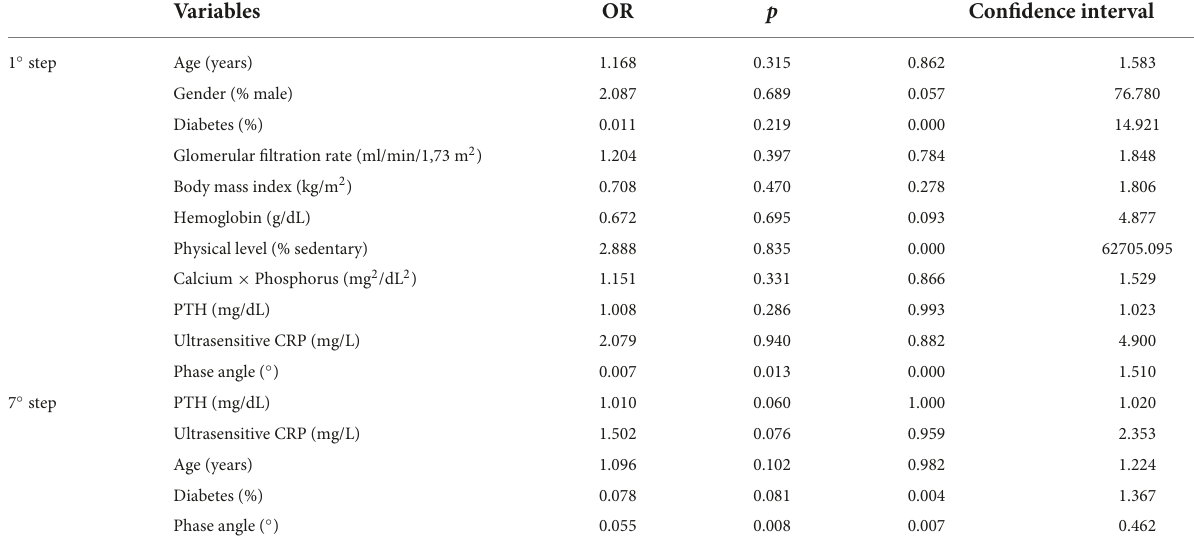
TABLE 5 Hierarchical multiple logistic regression with some variables related to the phase angle to predict positive ECAC. Variables OR p Confidence interval